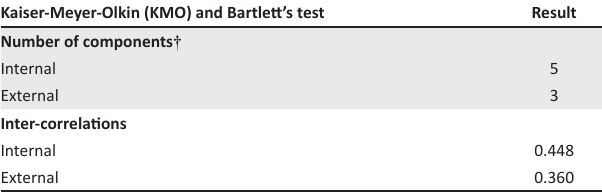
TABLE 2 : Ability to identify investment opportunities. TABLE 2 (Continues...): Ability to identify investment